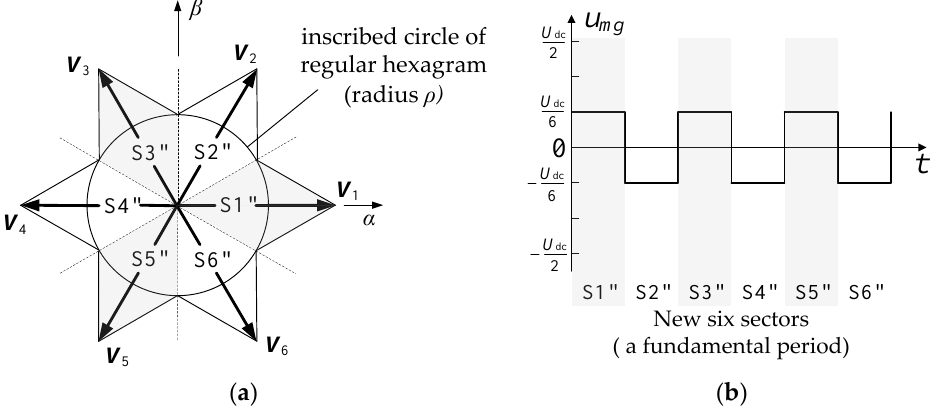
Figure 3. Common-mode reduction SVPWM and common-mode voltage waveform. ( a ) Figure3. Common-modereductionSVPWMandcommon-modevoltagewaveform. ( a )Common-mode Common-mode reduction SVPWM; ( b ) Common-mode voltage waveform in a fundamental period. reduction SVPWM; ( b ) Common-mode voltage waveform in a fundamental